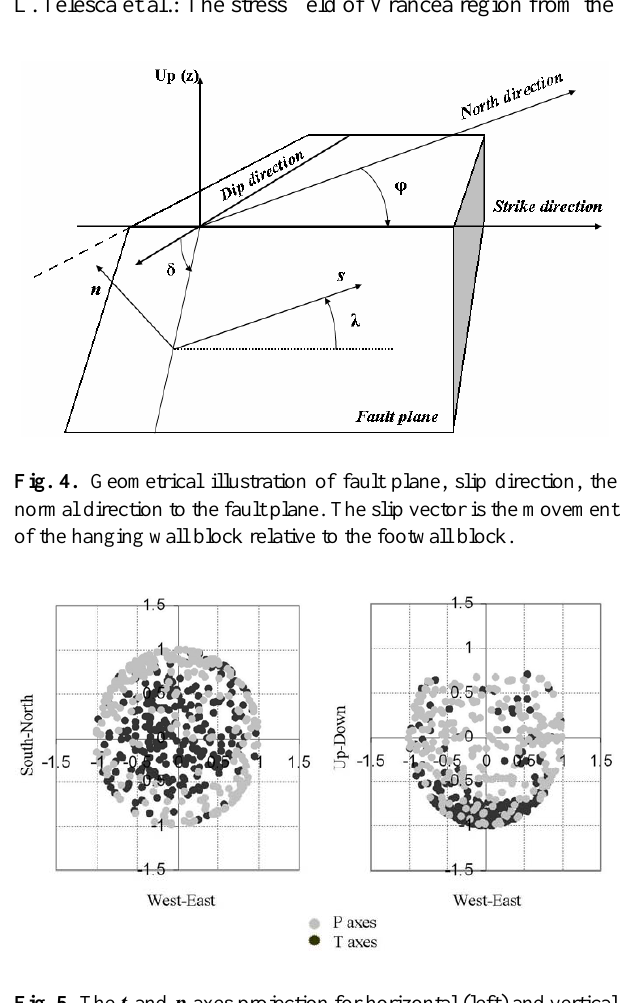
Fig. 5. The t and p axes projection for horizontal (left) and vertical Figure 5. The t and p axes projection for horizontal (left) and vertical (right) profiles. (right) profiles.